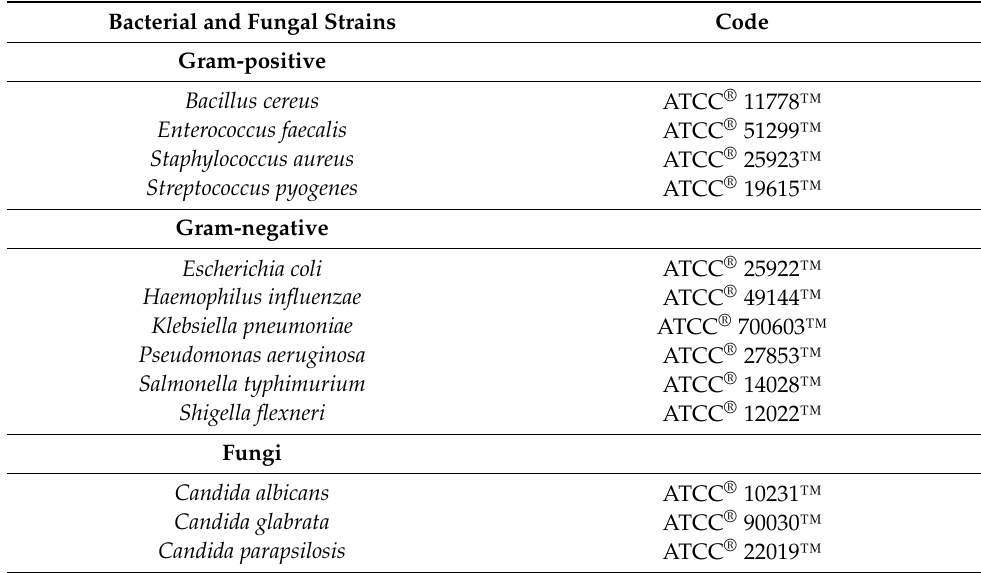
Table 1. Bacterial and fungal strains used to evaluate the antimicrobial potential of Melissa officinalis total